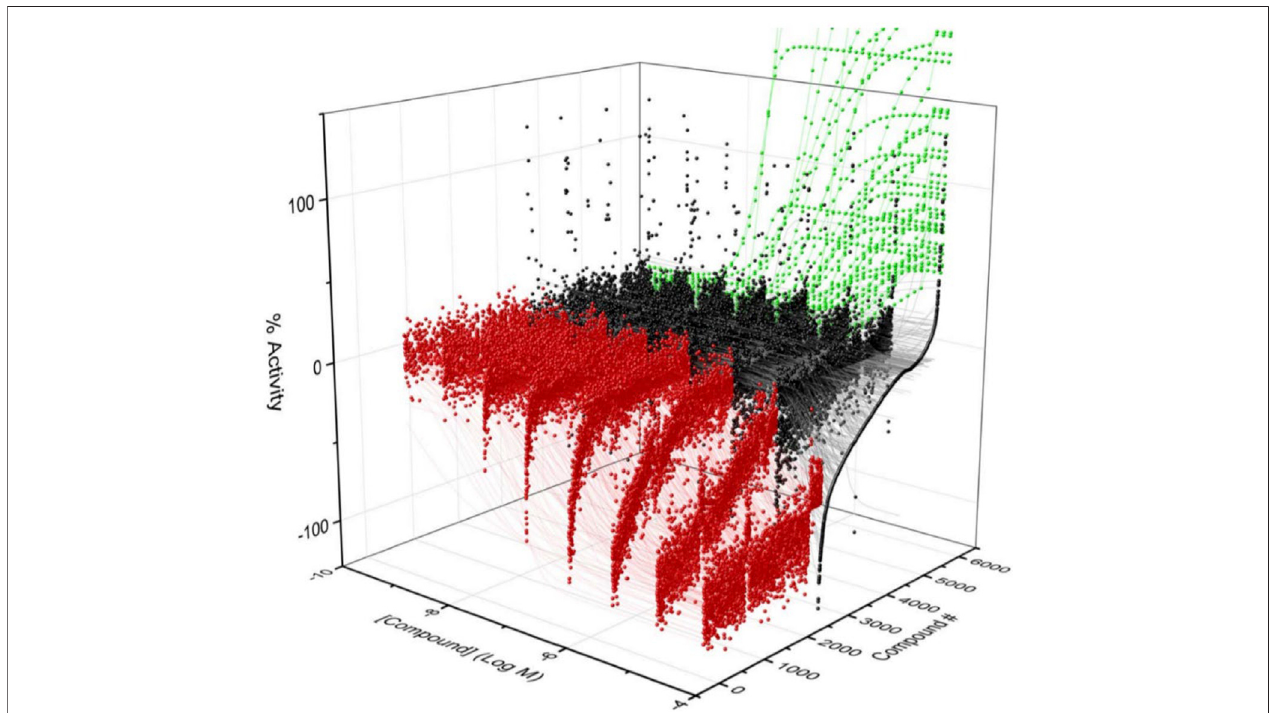
FIGURE 1 | Activity of CYP3A7 in the presence of ~5,000 test compounds at various concentrations. Red, black, and green represent inhibitors, inactives, and activators, respectively.